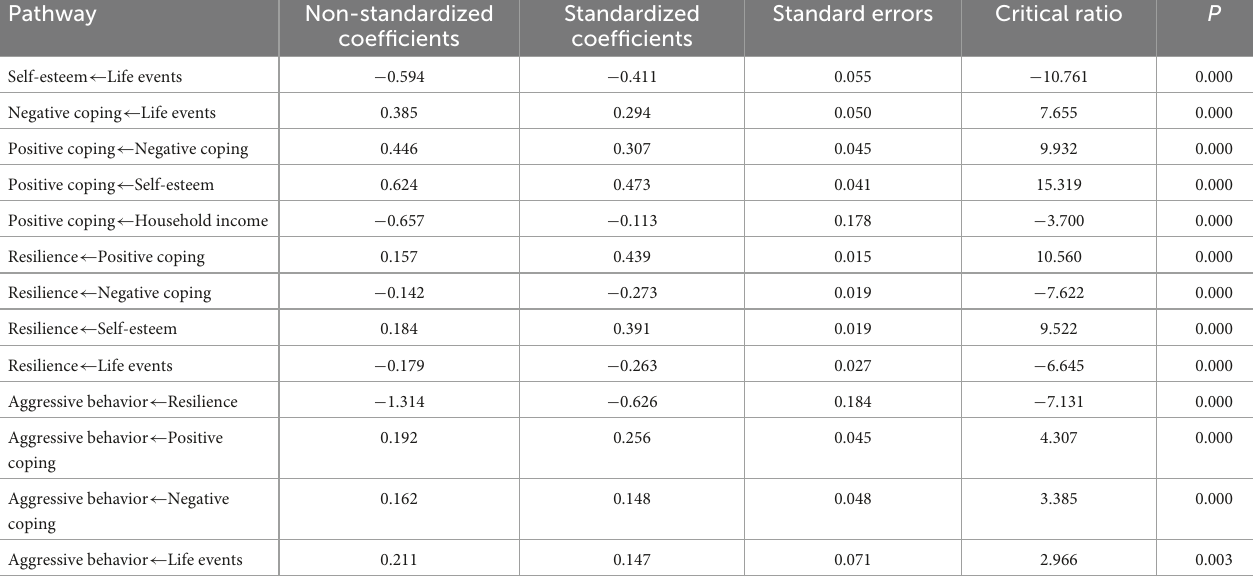
TABLE 6 Maximum likelihood estimates of the modified